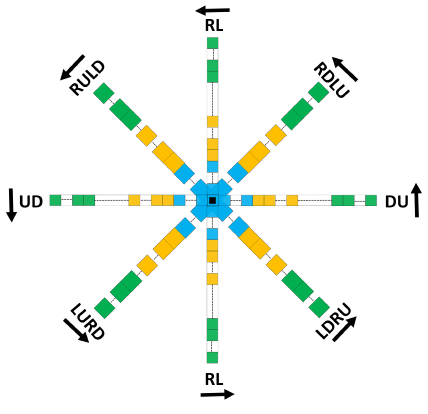
Figure 4. The general form of eight moving neighborhoods. Each color represents a mode and the reference cell is the black square in the middle of the